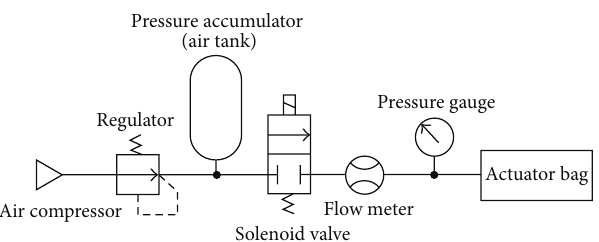
Figure 8: Pressure system for the